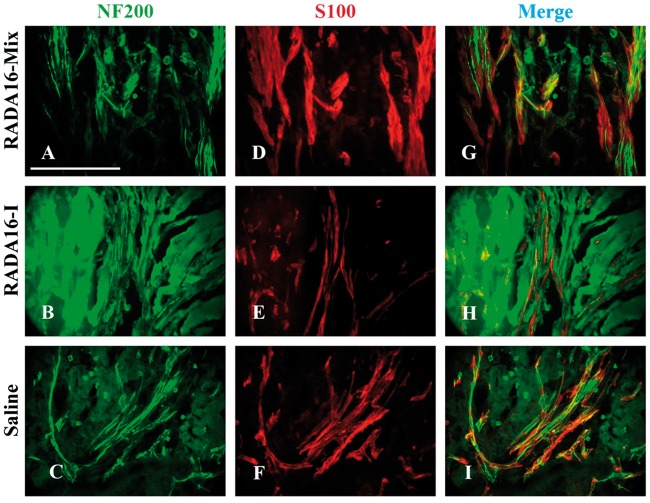
The longitudinal sections of the middle position 4 weeks after implanting different grafts. The axons were labeled by NF200 in green and Schwann cells were labeled by S100 in red. Scale bar: 200 μm.